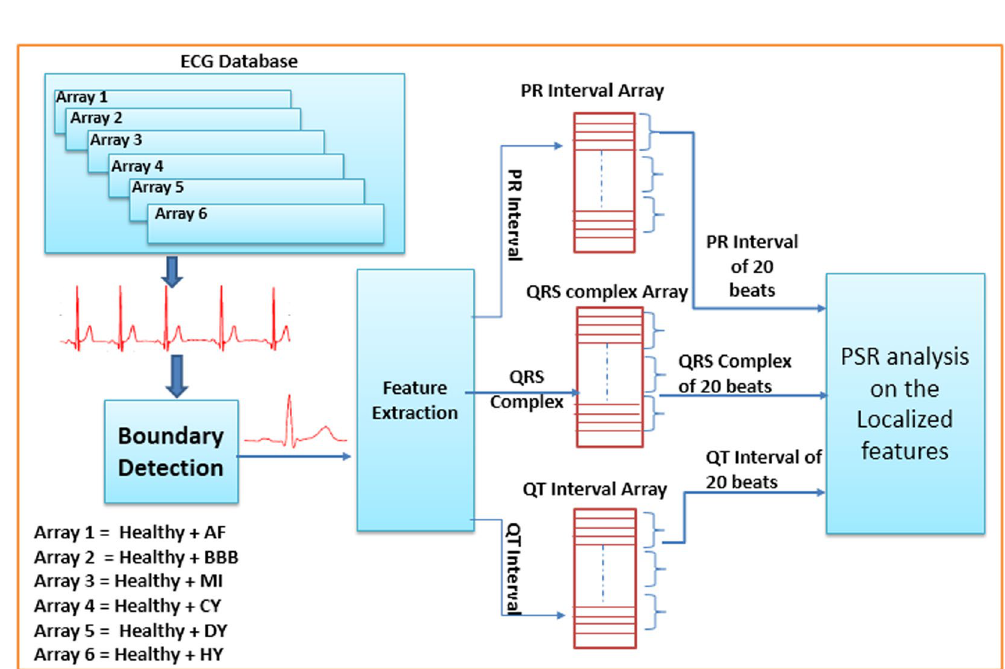
Figure 10. Block level diagram of the proposed